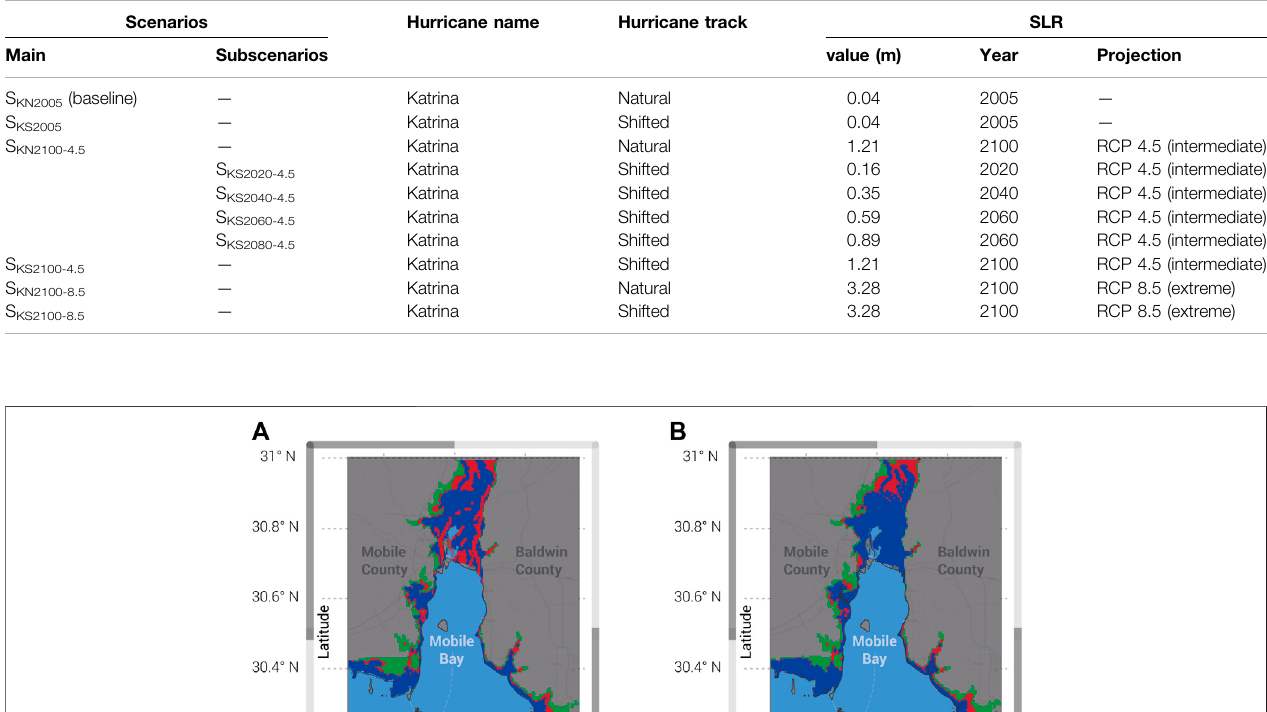
TABLE 2 | Inundation areas in Mobile and Baldwin counties under different